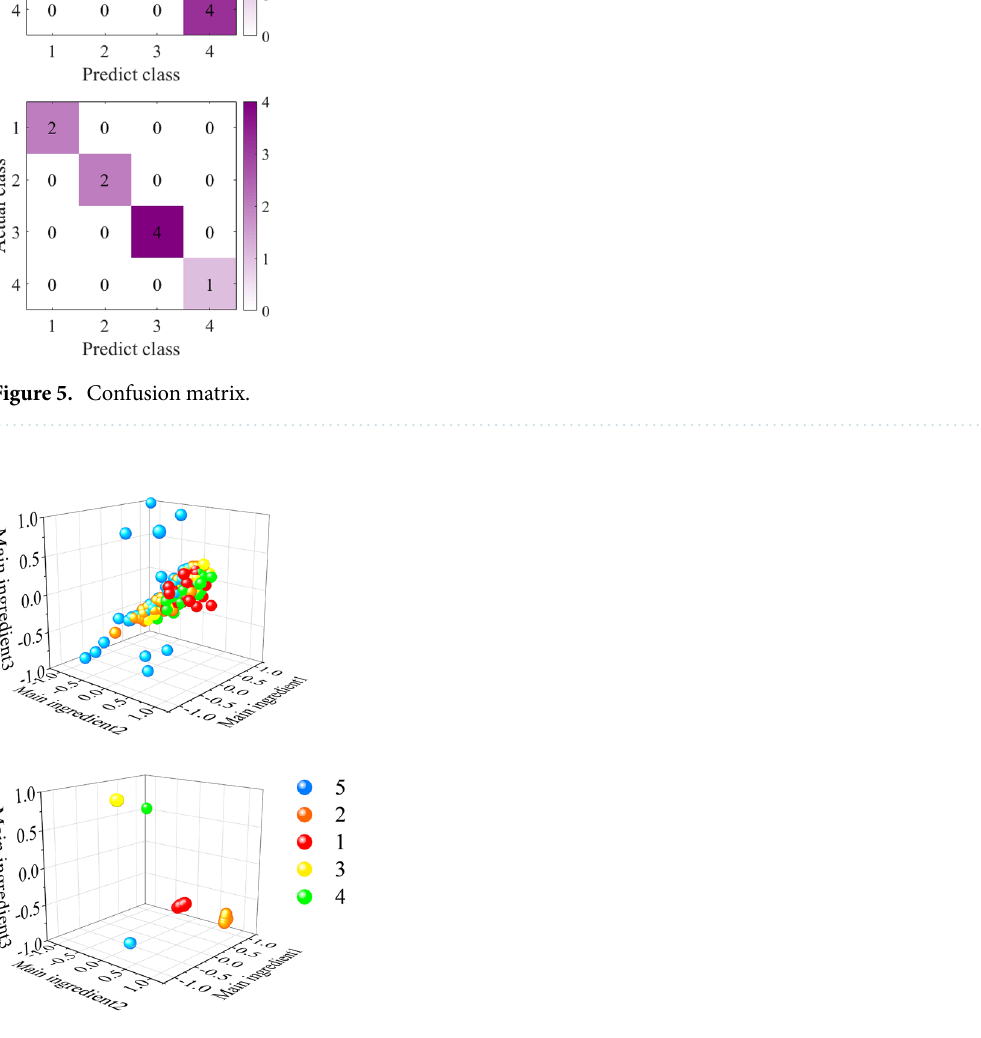
Figure 6. Visualization of bearing fault data of Xi’an Jiaotong